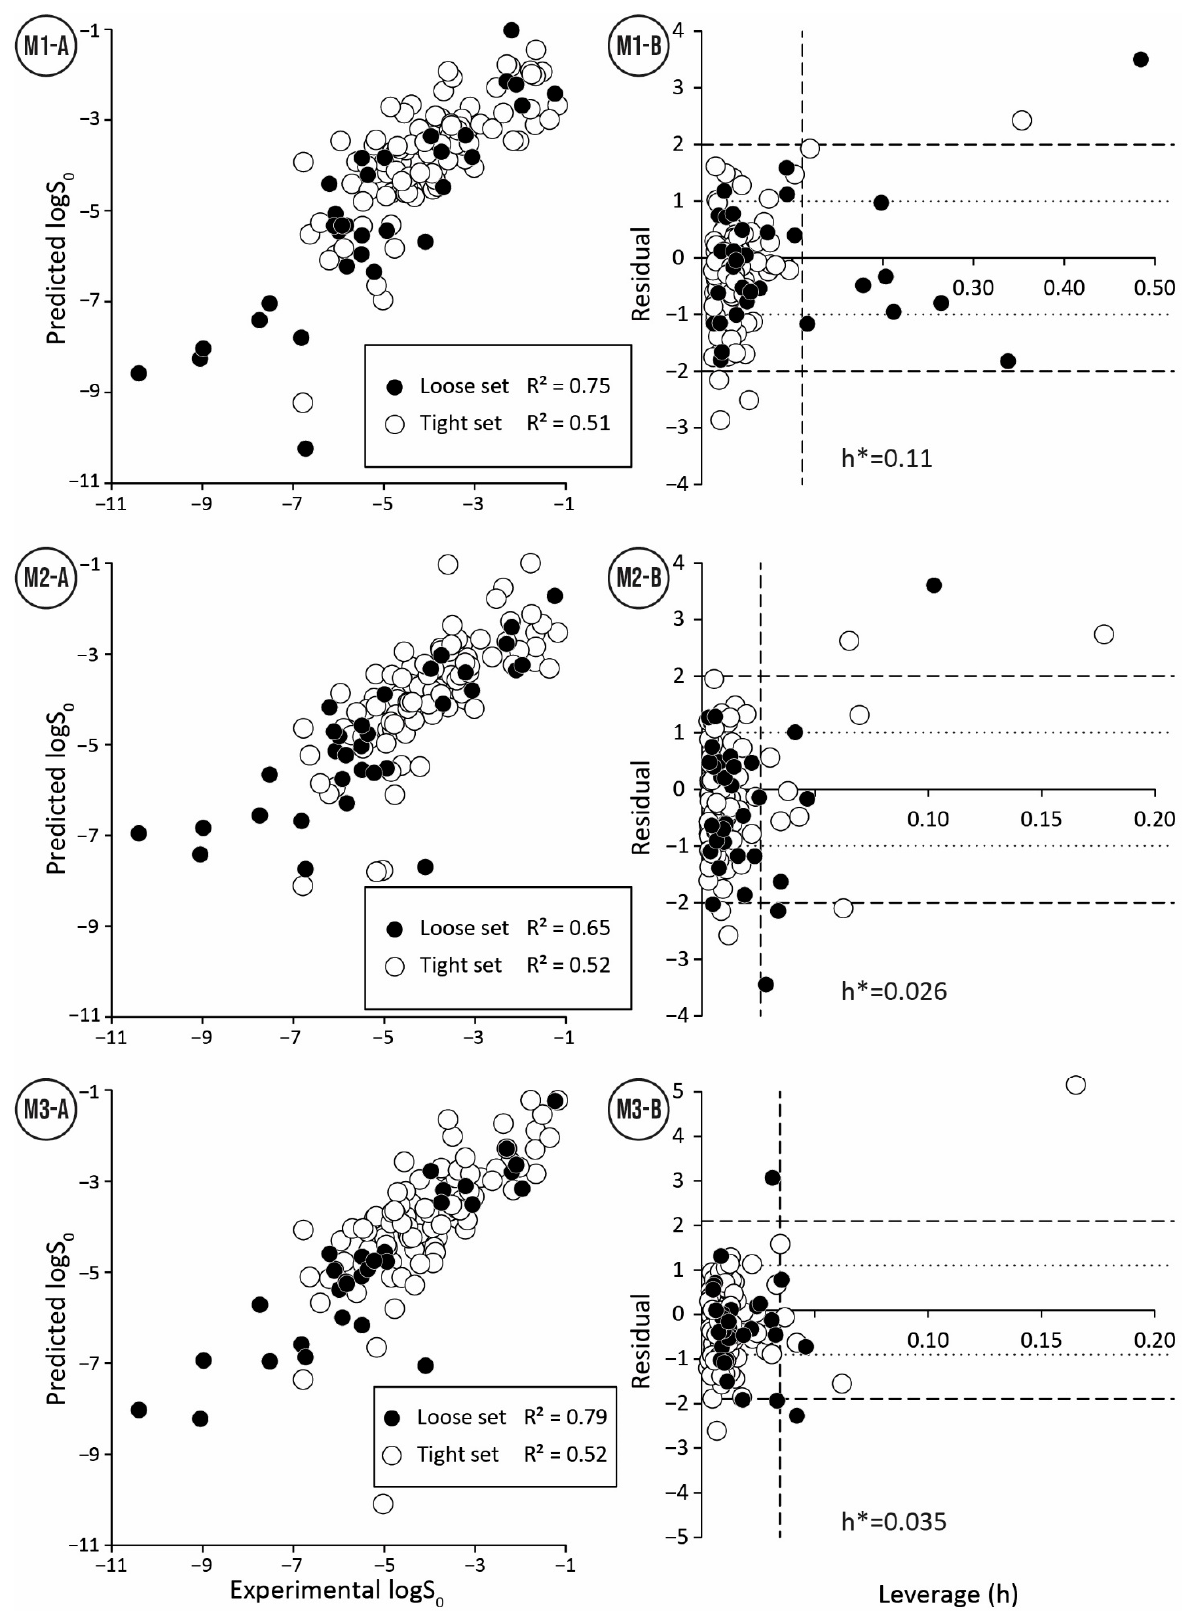
Figure 3. Relationship between experimental and predicted values ( A ) and Williams plots ( B ) for tight and loose test sets made by three QSPR models ( M1 – M3 ).